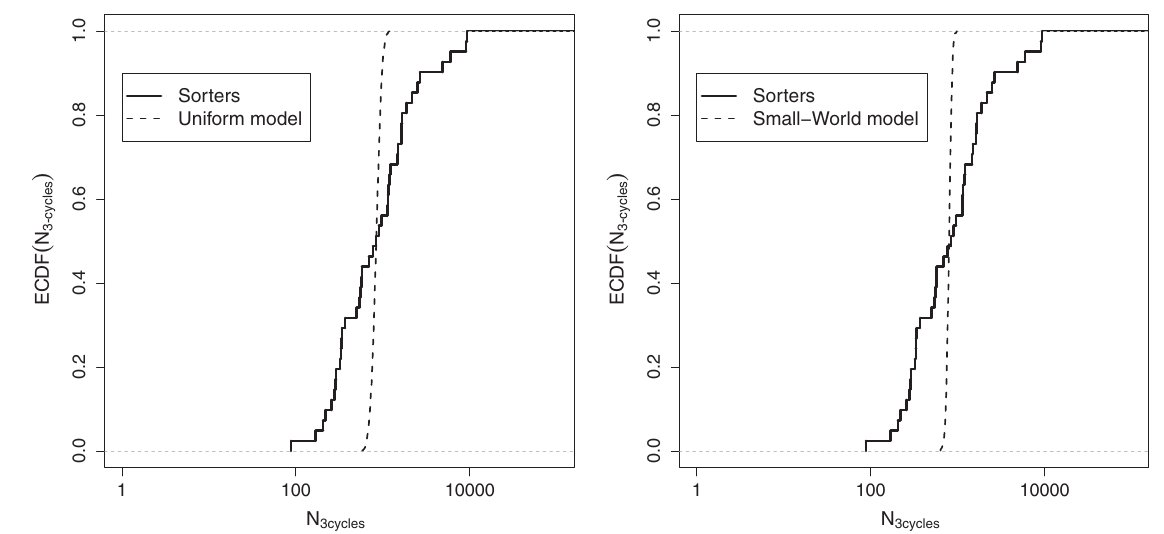
FIG. 9. 3-cycle distributions. On the left is an ECDF of the 3-cycle distribution for sorters and the Erdo¨s-Renyi model. On the right is the corresponding ECDF for the sorters and the Barabasi model. In both graphs the dashed line corresponds to the appropriate random model while the solid line corresponds to the sorter data.